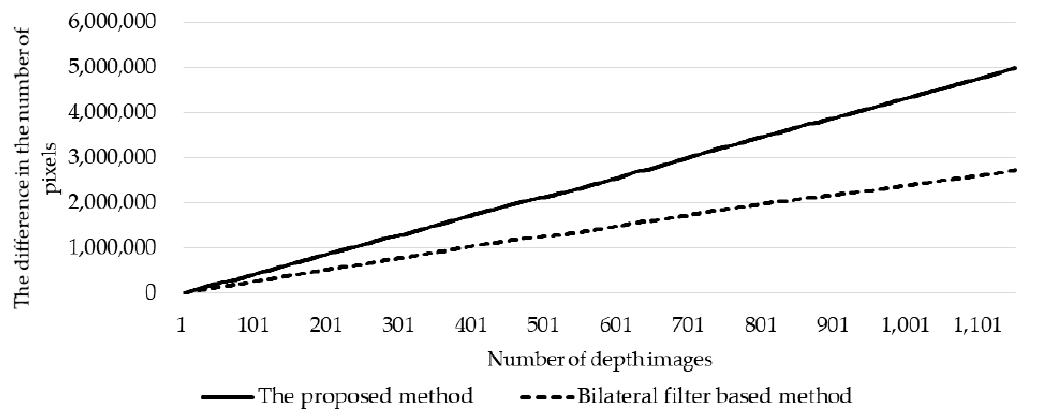
Figure 12. Comparison of 3D point cloud-based depth image, the improved density of the proposed method’s depth image, and up-sampled depth image based on the bilateral filter are accumulated.